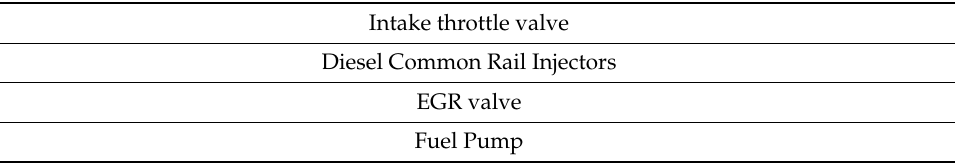
Table 1. Components available as real hardware in the HiL cabinet.